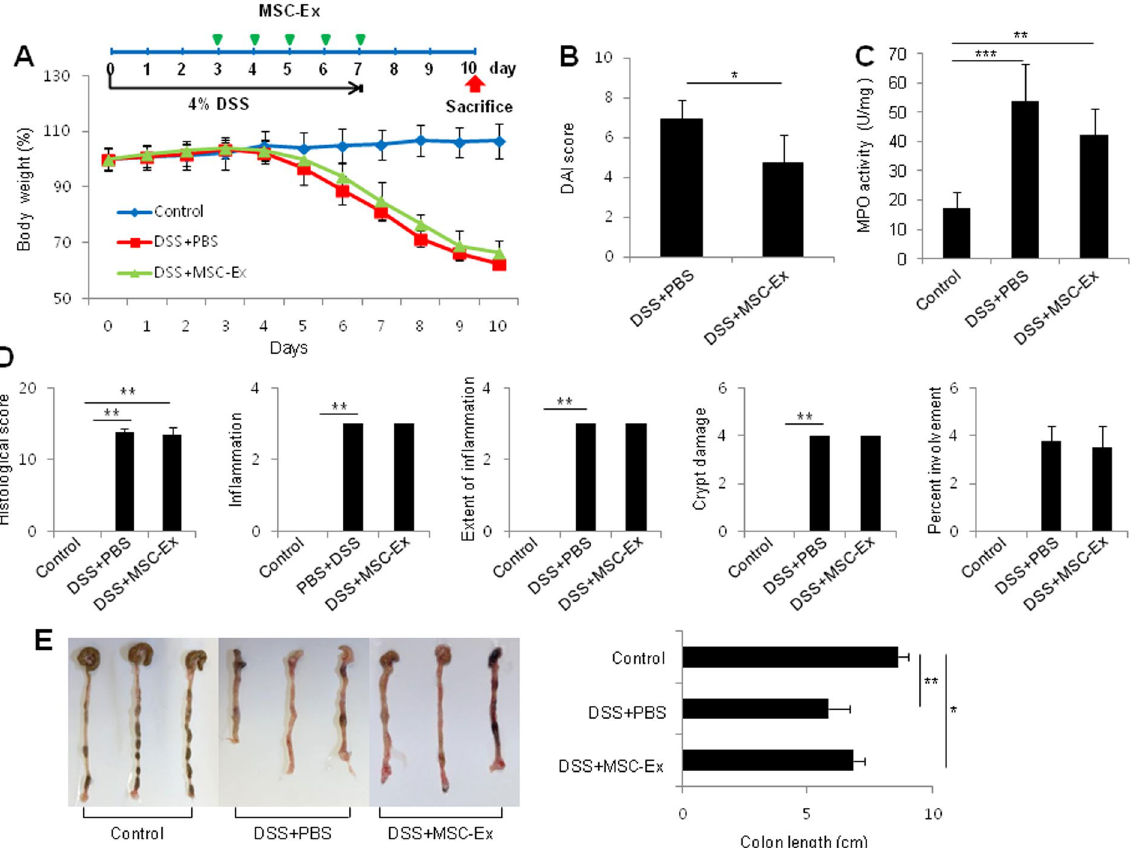
Figure 2. MSC-Ex injection attenuates DSS-induced acute colitis in mice. (A) The protocol for DSS-induced colitis and MSC-Ex injection (top). Weight loss was measured every day and expressed as the percentage change from day 0 (bottom). (B) The DAI scores were monitored as described in Fig. 1B. ( C ) The colonic MPO activity was measured at necropsy on day 7 following the DSS treatment. (D) Histological colitis scores of IBD were assessed by histology. (E) Macroscopic appearance (left) and length (right) of the colonic tissues. Data are represented as the means ± s.d. ( n ≥ 5 mice per group). * P < 0.05, ** P < 0.005, *** P < 0.001